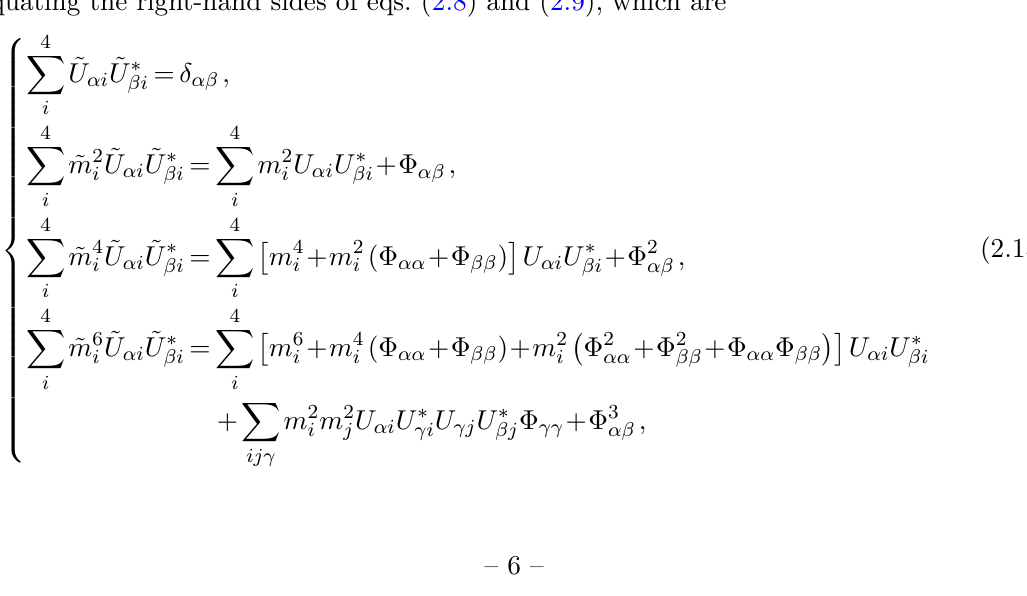
Figure 1 . E(cid:11)ective mass squares induced by neutrino interaction with matter, ~ m 2 blue, ~ m 2 in red and ~ m 2 in 3 4